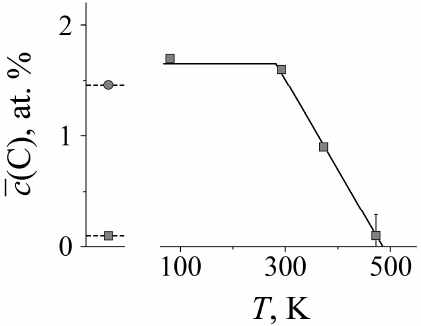
Figure 11. Spectra, p ( H ), and H for austenite of the steel Fe 64.7 Ni 33.6 C 1.7 . Treatment (state): ( a ) water-quenched from 1423 K (as-received); ( b ) annealed at 873 K for 1 h (aged); ( c ) aged and HPT treated at 298 K; ( d ) aged and HPT treated at 473 K. H AFM is the peak of antiferromagnetic component.